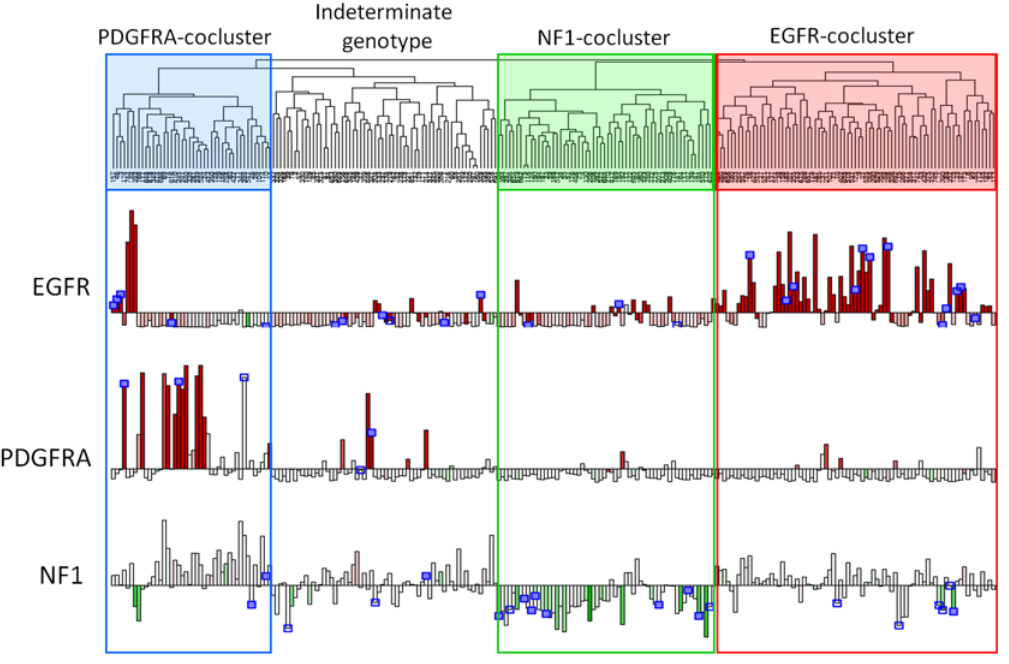
Figure 4. Unsupervised transcriptomal clustering of GBM from the TCGA dataset. Unsupervised hierarchical clustering of gene expression from 243 GBM samples in The Cancer Genome Atlas reveals four transcriptomal clusters, three of which are enriched for alterations of PDGFRA, NF1, and EGFR respectively. Expression data is from Affymetrix U133A and copy number is taken from Agilent 244K platform (TCGA Level 3 public data, see Methods). Gene expression for EGFR, PDGFRA, and NF1 is shown in the bar plots, colored according to gene copy number: amplification (red) or loss (green). Blue boxes denote samples with non-synonymous somatic mutations which have been validated (solid) or are pending validation (open). Three clusters are highlighted which show specific enrichment for lesions in genes encoding key signal transduction pathway members EGFR, PDGFRA and NF1. A fourth cluster lacks clear enrichment for any specific mutation or CNA.